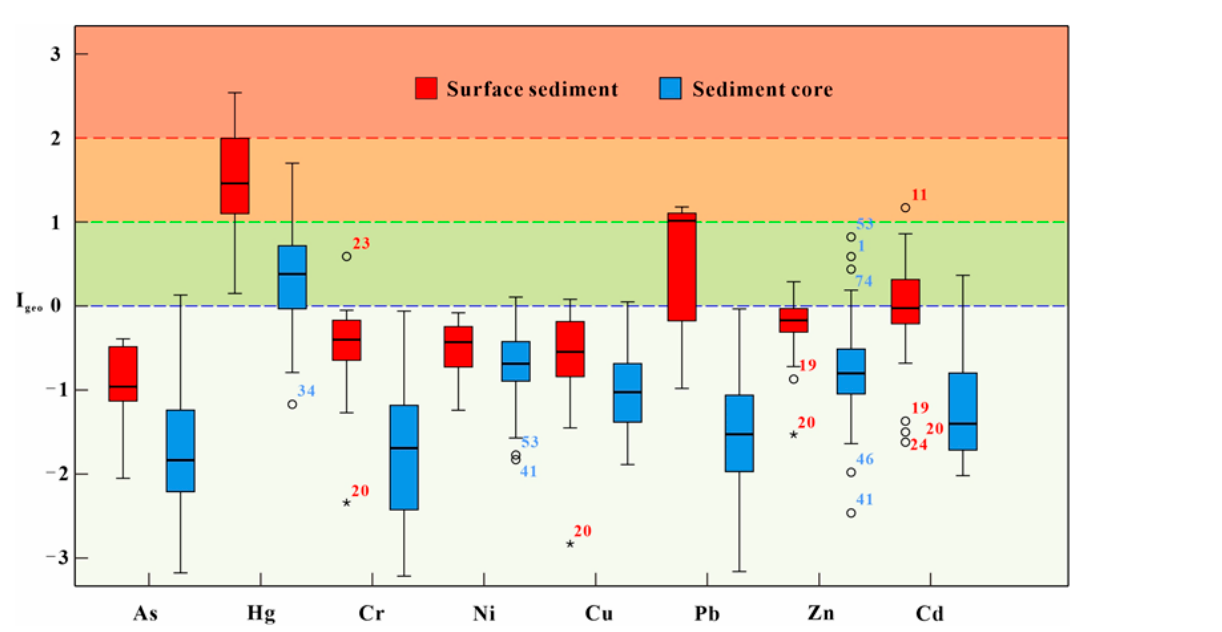
Figure 7. Box plot of Igeo in the surface sediments and sediment core of Yueliang Lake.